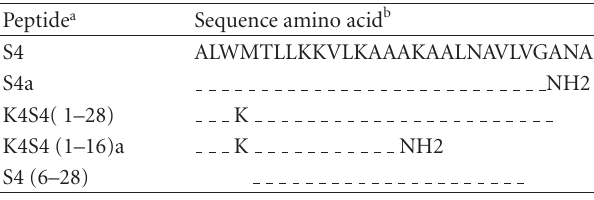
Table 1: Sequences of dermaseptin DS4 and its